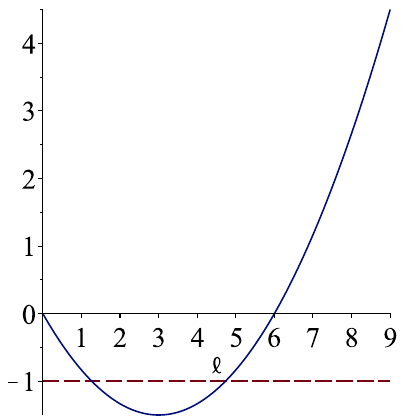
Figure 1 . Violation of the BF bound in the BSB (cid:13)ux vacuum for (cid:12) = 1. The dangerous eigenvalue is displayed in units of 1 , and the BF bound is -1 in this case. Notice the peculiar R 2 AdS